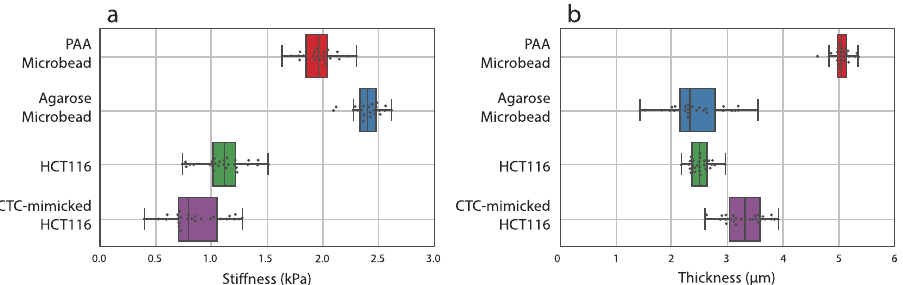
respectively. CTC-mimicking cells had a lower stiffness value compared to their epithelial counterparts. One-way ANOVA comparison yielded P =2 : 20e (cid:1) 7 ( F =36 : 64, η 2 =0 : 186) for ( a ) and P =1 : 25e (cid:1) 6 ( F =45 : 71, η 2 =0 : 172) for ( b ). Box plotcentersshowmedian,boxboundsshowinterquartilerangeandwhiskersshow 10th to 90th percentile.